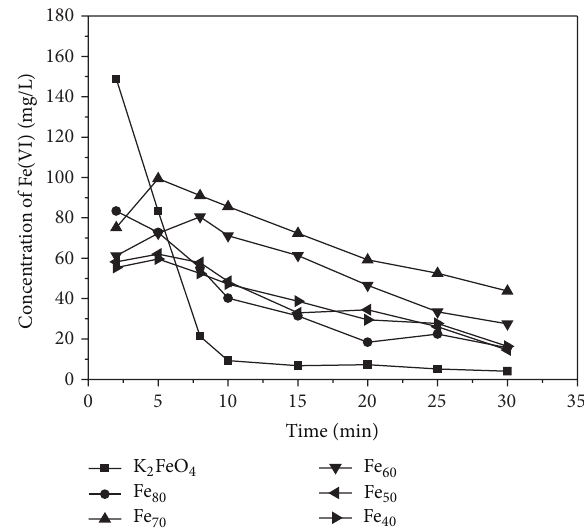
Figure 4: Ferrate release rate from sustained-release K 2 FeO 4 sam- ples.(Experimentalconditions:icewaterbath,60 rpmagitation,and initial pH = 7.4 ∼ 7.6.)